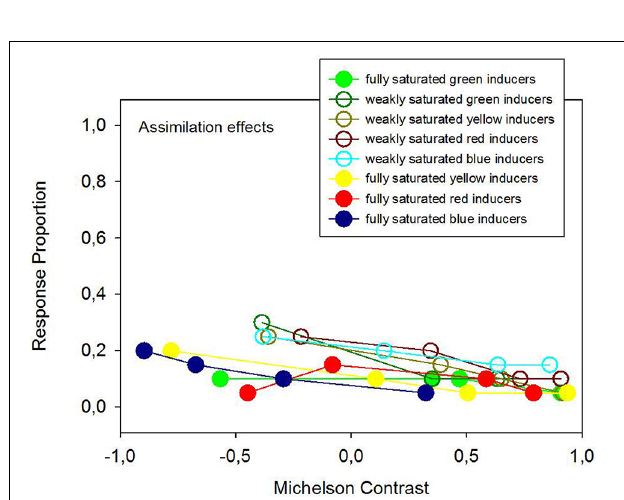
FIGURE 4 | Average response proportions for contrast effects as a function of hue, Michelson contrast, and saturation levels of the colored inducers. Although 2 × 2 ANOVA on these means (analysis 1) did not signal statistically significant effects of hue and saturation, there is a systematic trend for fully saturated hues to produce stronger contrast effects compared with weakly saturated hues.